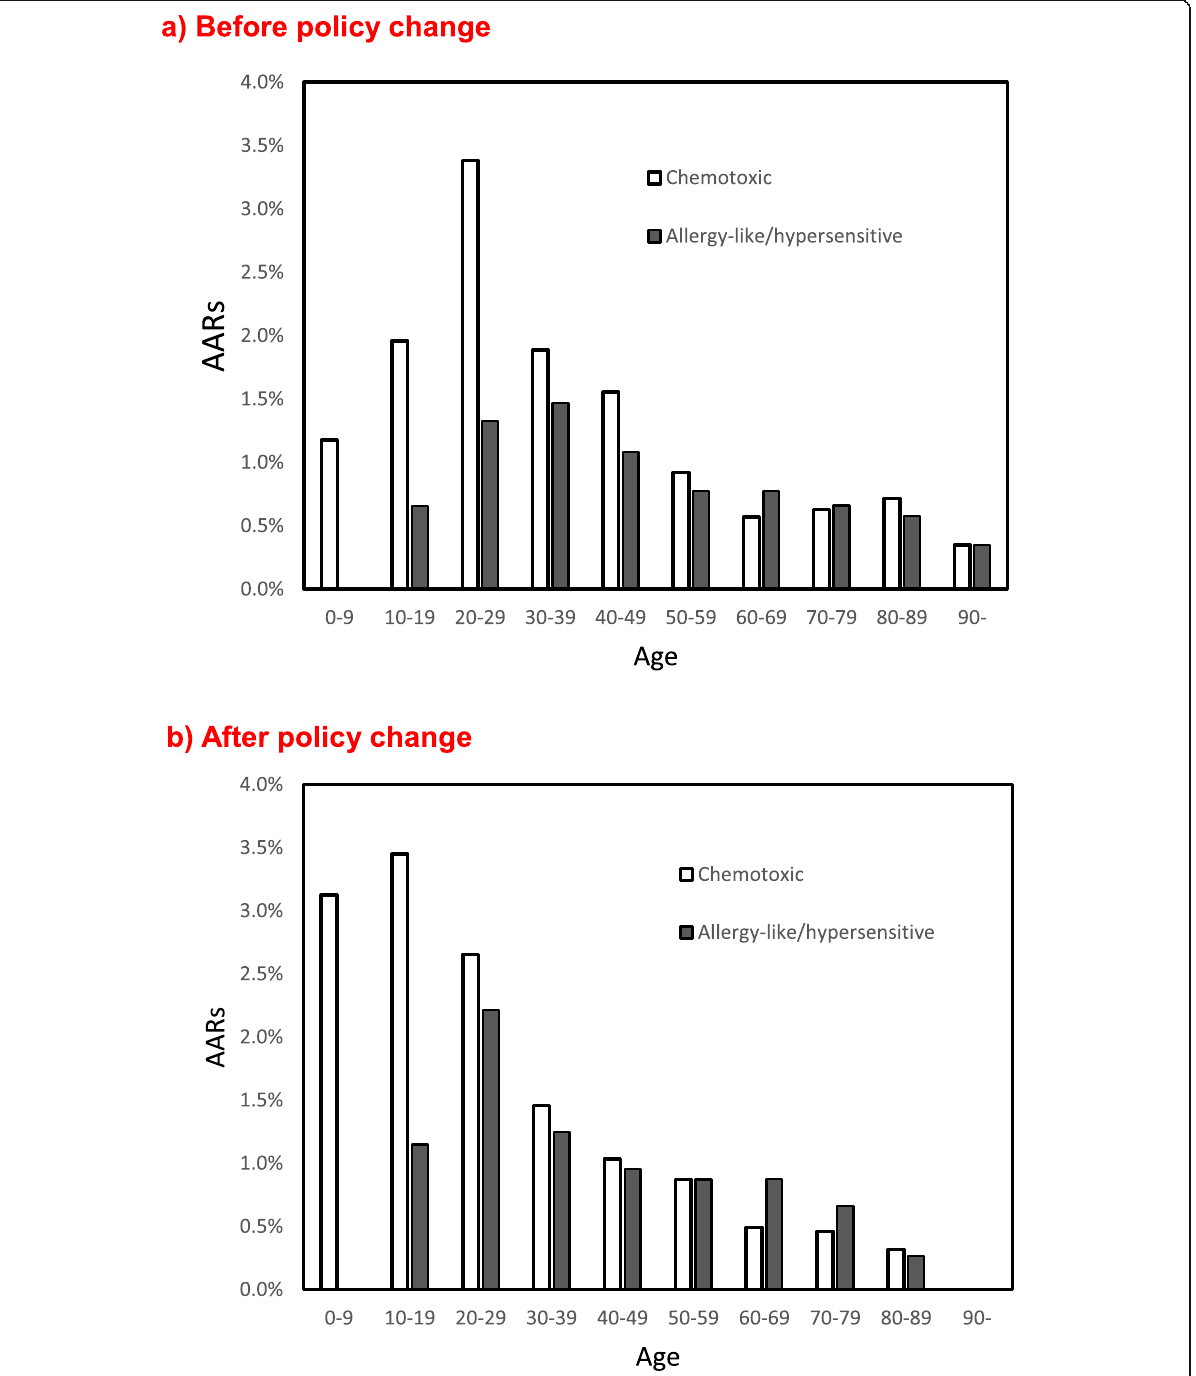
Fig. 2 Incidence of adverse reactions by age. a Before the policy change. b After the policy